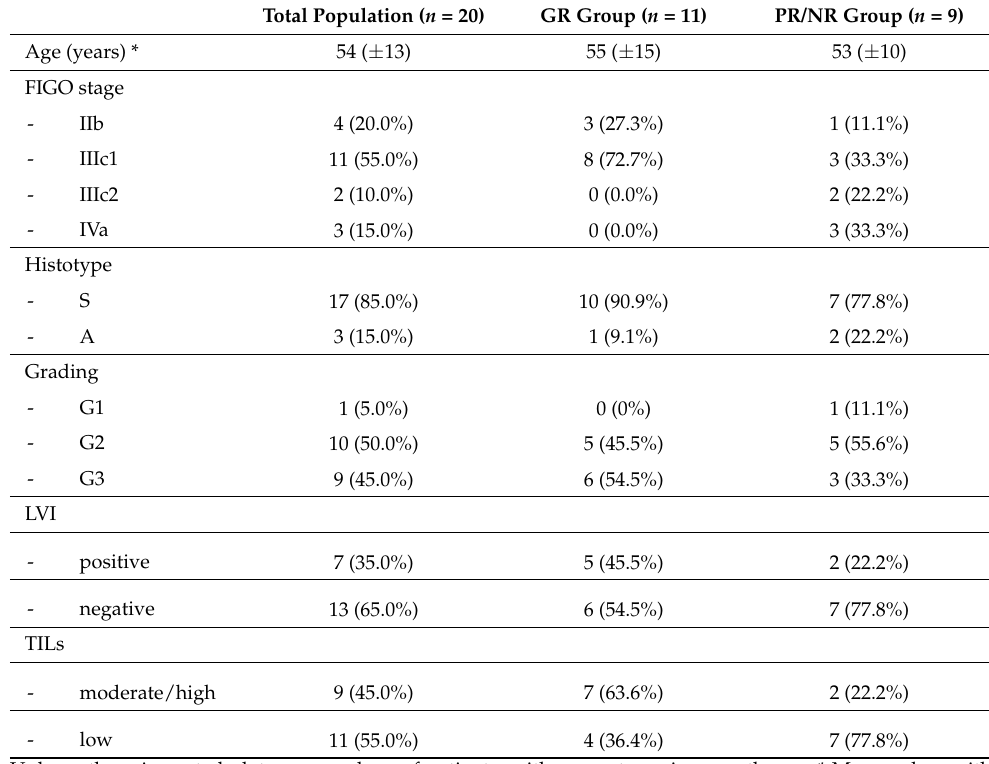
Table 2 . Patients’ Characteristics . Table 2. Patients’ Characteristics.